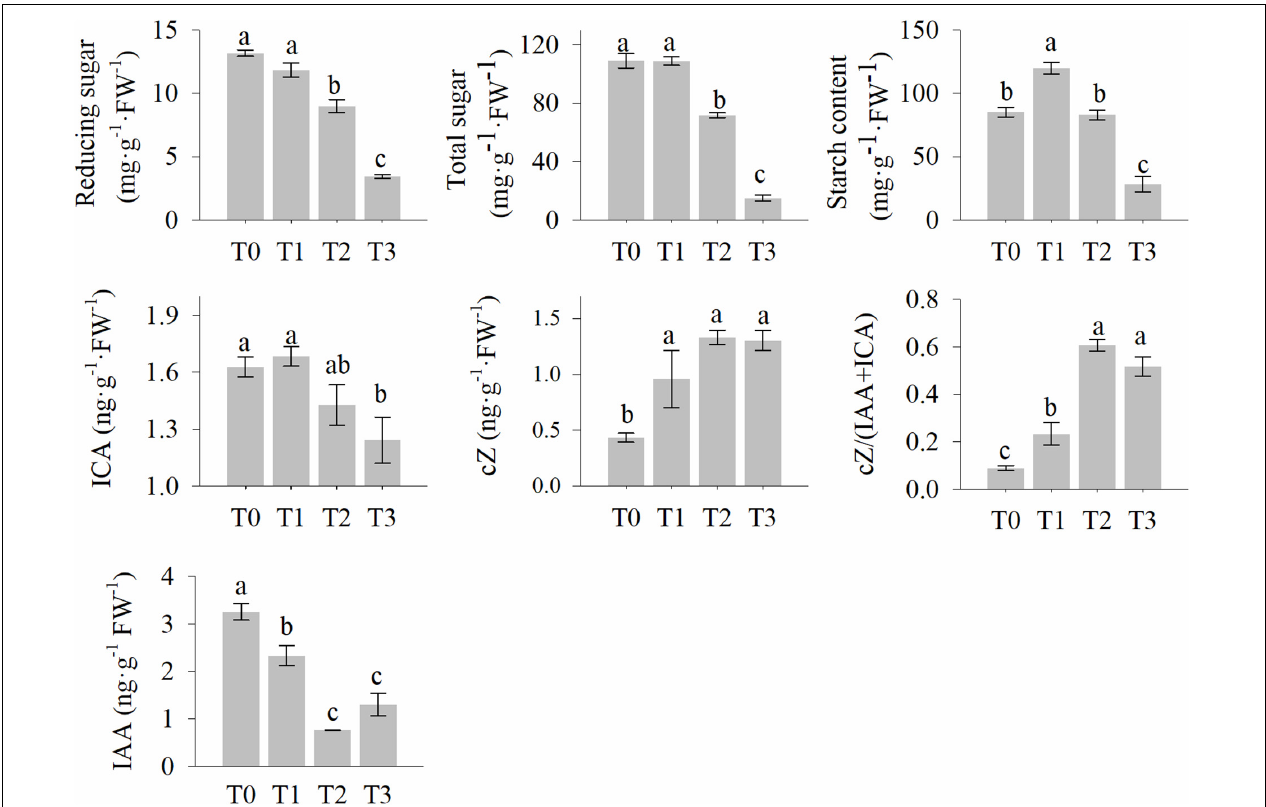
FIGURE 2 | The levels of starch, soluble sugar, and phytohormone in wheat stubble after mowing. Data are the mean values (all measurement were conducted at least three biological replicates), and error bars show the standard error. Duncan’s multiple-comparison test was used for ANOVA, and different lowercase letters indicate a significant difference at the level of P < 0.05. T0, T1, T2, and T3 represent the samples harvested at 0, 2, 24, and 72 h after